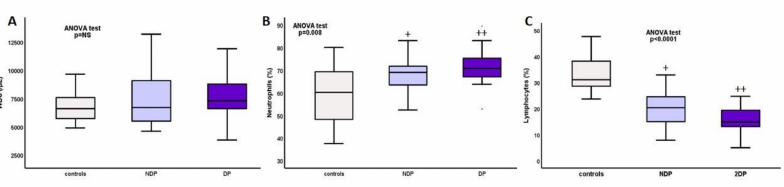
Figure 1. Total numbers of ( A ) white cells, ( B ) neutrophils (%), and ( C ) lymphocytes (%) in DM, NDM, and controls. + p NDM vs. controls <0.01, ++ p DM vs. controls <0.0001. Moreover, the ratio of neutrophil/lymphocyte count (NLR) was significantly increased in DM and NDM compared to that in the controls, with mean rank 37.85 vs. 31.57 vs. 12.73, respectively, p < 0.0001; and the ratio of neutrophil/lymphocyte percentage, mean rank 37.65 vs. 31.67 vs. 12.67, respectively, p <